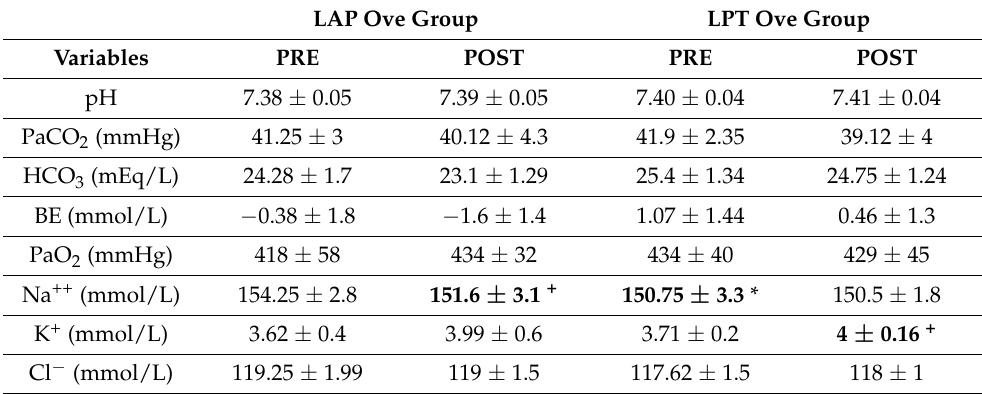
Table 1. Pre- and postoperative arterial blood analysis.